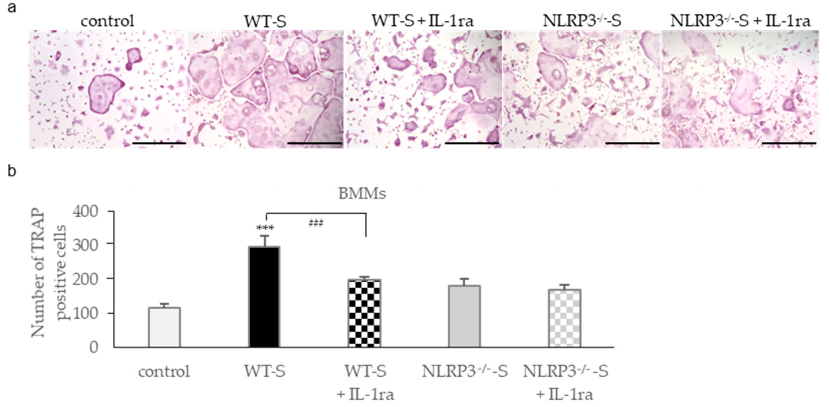
Figure 4. Effects of recombinant (r)IL-1ra on osteoclastogenesis. BMMs were incubated with 30 ng/mL M-CSF and 20 ng/mL RANKL for 48 h. Then, the cells were incubated for 24 h with the same concentration of M-CSF, RANKL, and culture supernatant from WT or NLRP3 − / − mouse macrophages stimulated with DC in the presence or absence of 10 µ g/mL rIL-1ra. These cells were subjected to TRAP staining ( a ), and TRAP-positive cells with more than three nuclei were counted ( b ). Scale bar = 500 µ m. The differences between the groups were analyzed by one-way ANOVA followed by a Tukey test for multiple comparisons. *** p < 0.001 compared with the con- trol. ### p < 0.001 compared among the test groups. BMM, bone marrow macrophage; M-CSF, macrophage colony-stimulating factor; NLRP3 − / − -S, culture supernatant from NLRP3-deficient mouse macrophages stimulated with DC; TRAP, tartrate-resistant acid phosphatase; WT, wild-type; WT-S, culture supernatant from wild-type mouse macrophages stimulated with DC.